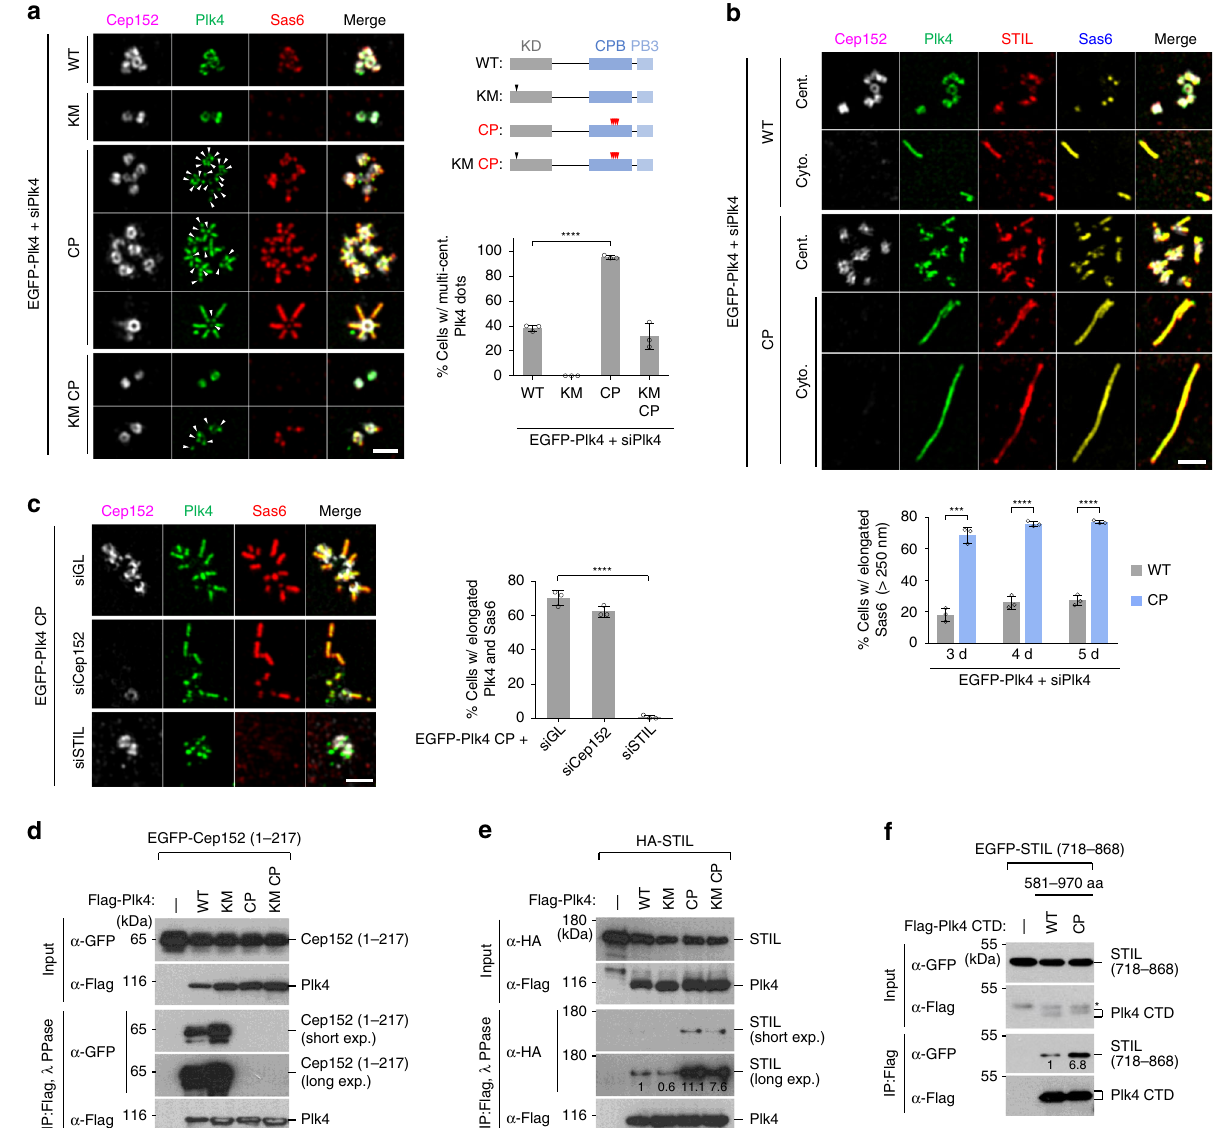
Fig. 2 A condensation-pro fi cient Plk4 CP mutant drives procentriole formation by switching its interaction from Cep152 to STIL. a , b 3D-SIM analysis of immunostained U2OS cells stably expressing the indicated EGFP-Plk4 constructs under Plk4 RNAi (siPlk4) conditions. Bar, 1 μ m. Quanti fi cation of images is shown in mean ± s.d. ( n = 3 independent experiments). Arrowheads in a , dot-state Plk4 signals; schematic diagram in a shows the sites of the KM and the quadruple CP mutations. Elongated procentrioles in both centrosome (cent.) and cytosol (cyto.; as judged by the absence of the centrosomal Cep152 signal) are shown in b . *** P < 0.001; **** P < 0.0001 (unpaired two-tailed t test). c 3D-SIM analysis of immunostained U2OS cells stably expressing the EGFP-Plk4 CP mutant under various RNAi conditions. Bar, 1 μ m. Quanti fi ed data are shown in mean ± s.d. ( n = 3 independent experiments). **** P